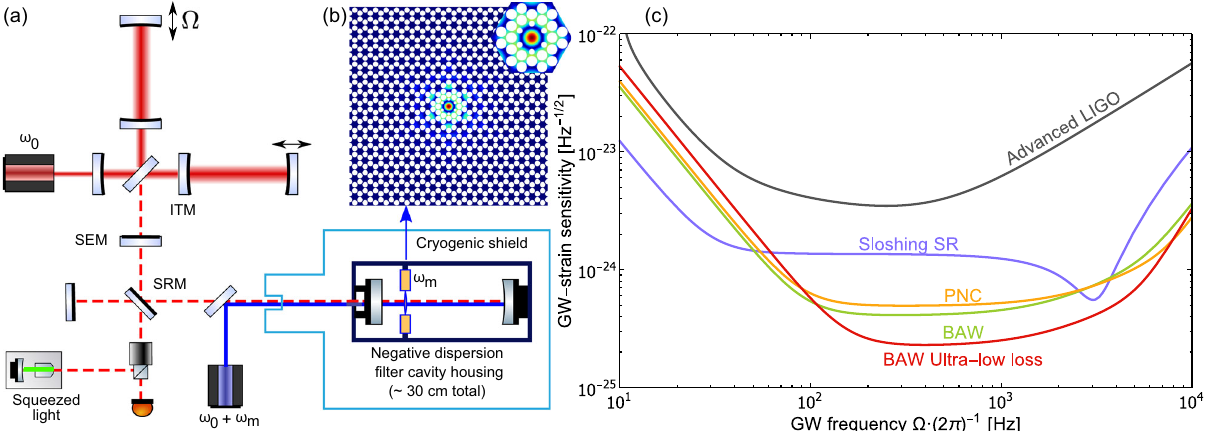
Fig. 1 White light signal recycling (WLSR) interferometer con fi guration using optomechanical negative dispersion. a Gravitational waves (GW) of frequency Ω modulate the interferometer carrier ω 0 , producing sidebands at ω 0 ± Ω . The input test mass (ITM) and signal extraction mirror (SEM) are impedance matched for maximum sideband transmission. The signal recycling mirror (SRM) couples the interferometer dark port, fi lter cavity and output photodetector. The fi lter cavity is pumped with light blue detuned by the mechanical resonance ω m . The cavity itself is 5 cm long but may be contained inside a larger housing. b Illustration of the phononic crystal (PNC) resonator consisting of a silicon nitride membrane in a phononic lattice. The colour scale represents out-of-plane mechanical mode displacement. The inset shows a magni fi ed view of the resonator. (Image acknowledgement: E.C. Langman, Neils Bohr Institute) c Quantum noise-limited sensitivity curves of various GW detectors. “ Advanced LIGO ” denotes the nominal design sensitivity shown in the ref. 49 at 800 kW arm cavity power. “ Sloshing SR ” refers to a detector where the signal recycling cavity is tuned to achieve an optical resonance at a speci fi c frequency 25 . WLSR setups using the PNC and bulk acoustic wave (BAW) resonator are denoted with their respective abbreviations. The curve “ BAW Ultra-low loss ” shows the speculative improvement when the BAW resonator is cooled to 1 K. Apart from “ Advanced LIGO ” , all curves use 4.0 MW arm cavity power and 10 dB frequency dependent Table 1 Properties of candidate resonators: these properties of the mechanical resonators are used to produce the calculations throughout this paper.